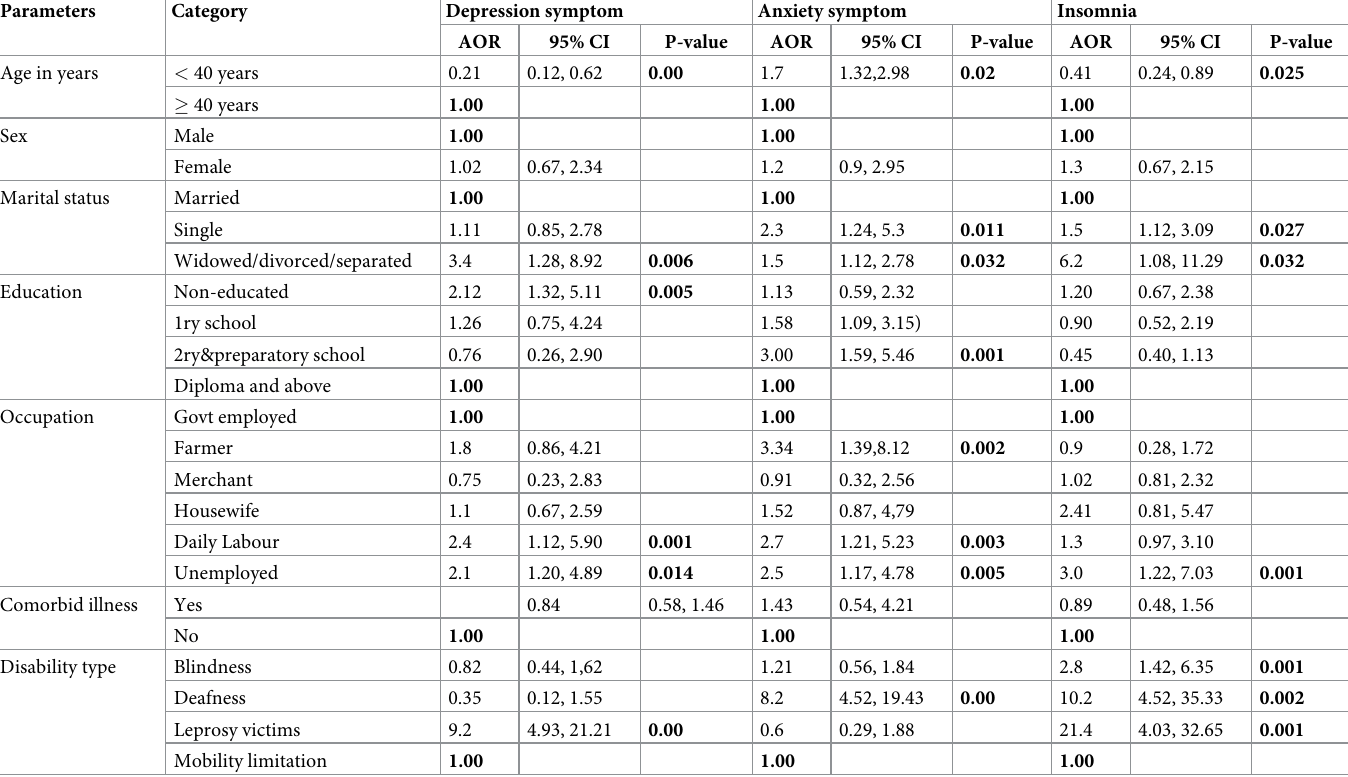
Table 4. Factors associated with depression symptom, anxiety symptom, and Insomnia in individuals with a disability during the COVID-19